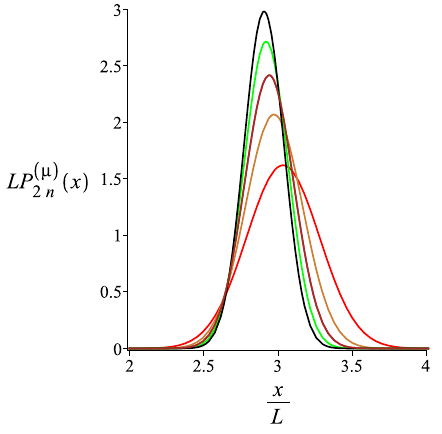
Figure 8. The probability density of the x component of the position of the free endpoint of the grafted structure with an even number of arms. The red, gold, brown, green, and black are associated = 12.5 i , where i = 1,2,3,4,5, respectively. The with the fixed values of the stiffness parameter, l p L other fixed parameters are: ω = π , φ µ = 0, φ B = 0 n = 2, and K B = 4